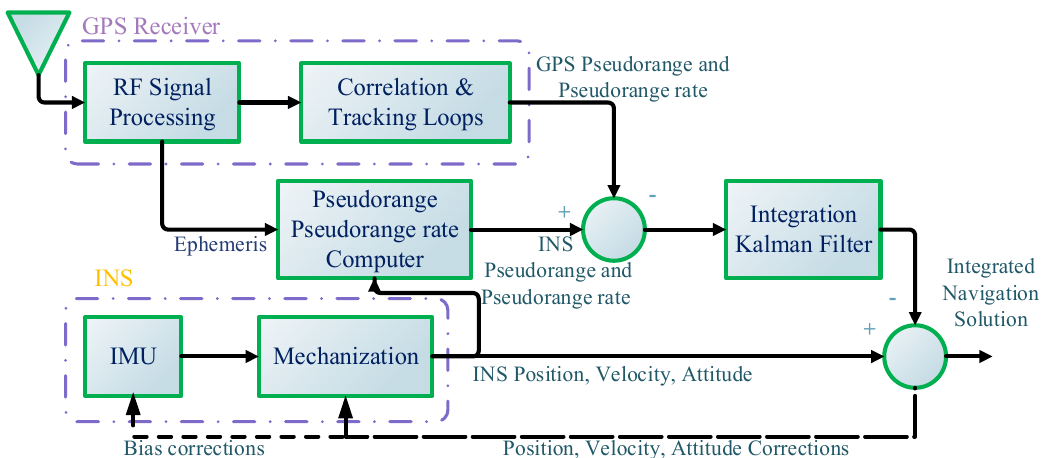
Figure 1. A tightly coupled GNSS/INS integration architecture.